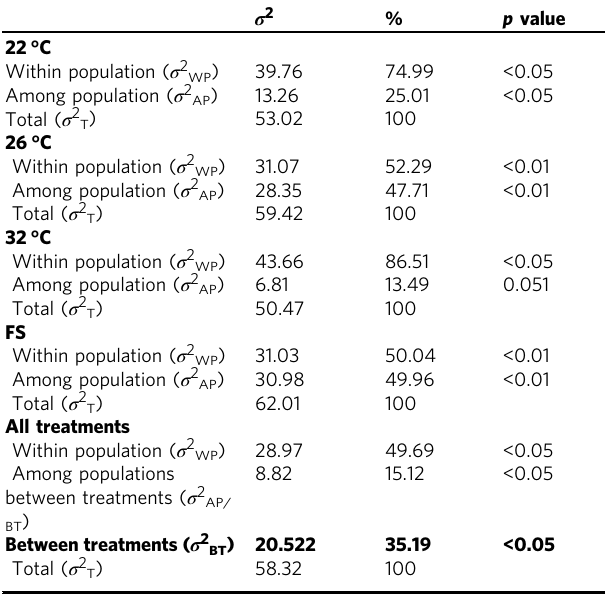
AMOVArevealedthatasigni fi cantproportionofthevarianceinSNVfrequenciesat speci fi cloci was attributable to differences between treatments. Within individual treatments, there was signi fi cant variation between biological replicates ( “ populations ” in the table), with the